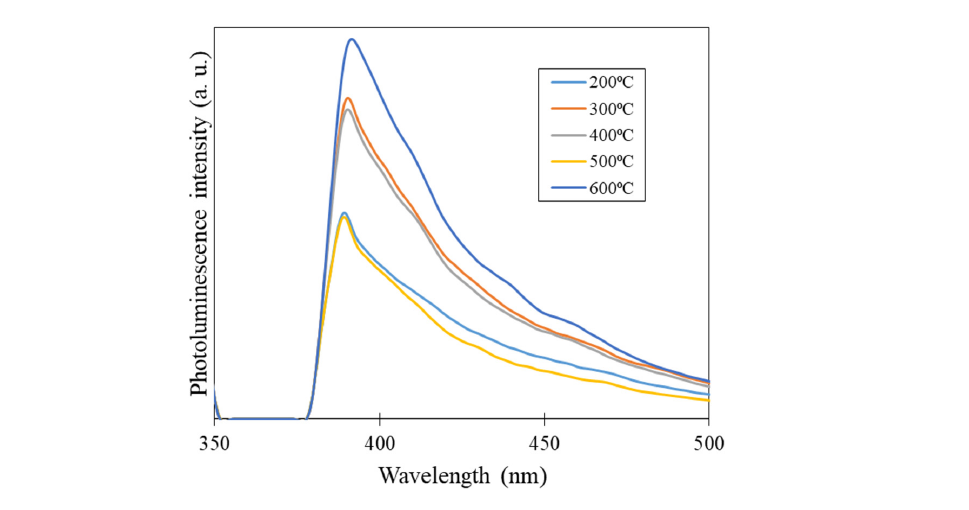
Figure 2. PL spectrum of the G. mangostana L. leaf extract-mediated synthesized CuO NPs at different calcination temperatures.